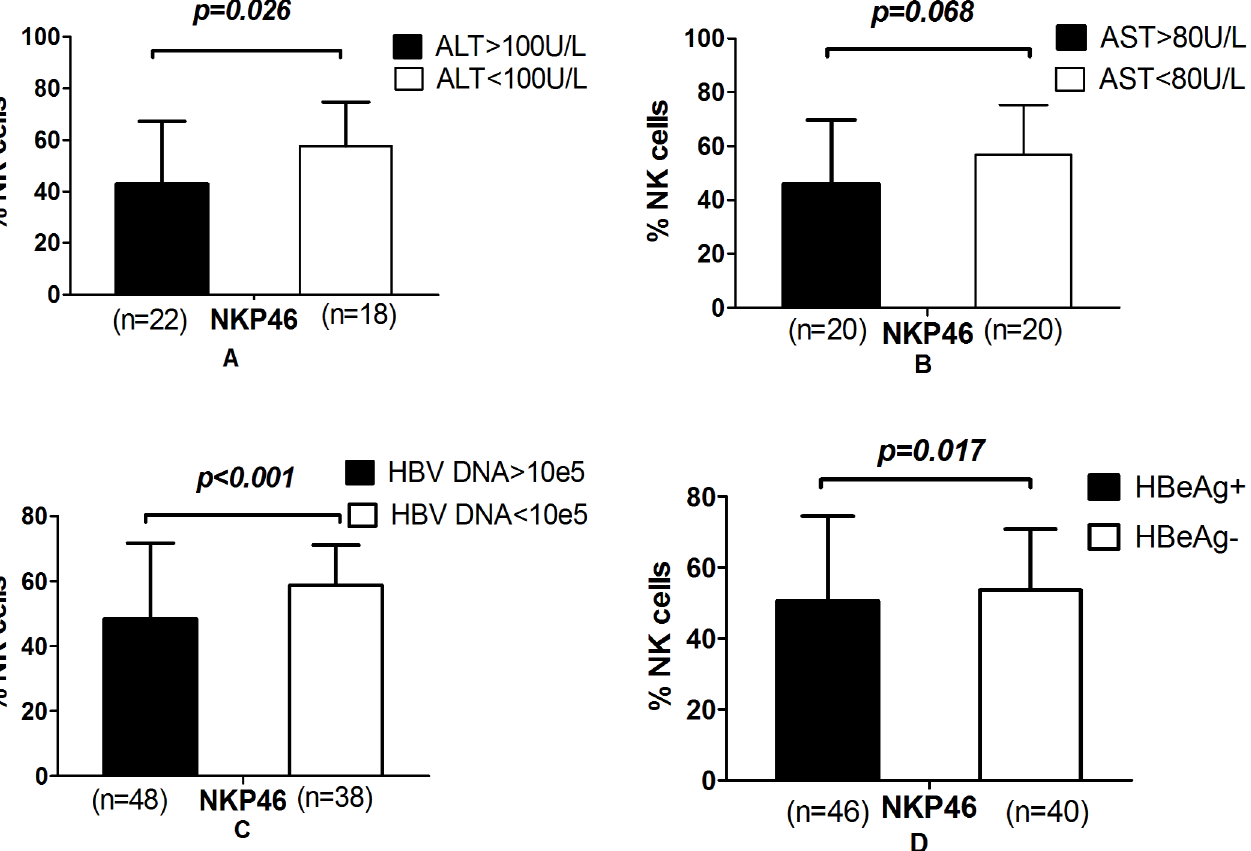
Fig 2. NKp46 was decreased in the high alanine aminotransferase, high viral load and HBeAg positive groups. (A) Groups divided by ALT level. (B) Groups divided by AST level. (C) Groups divided by HBV DNA levels. (D) Groups divided by HBeAg